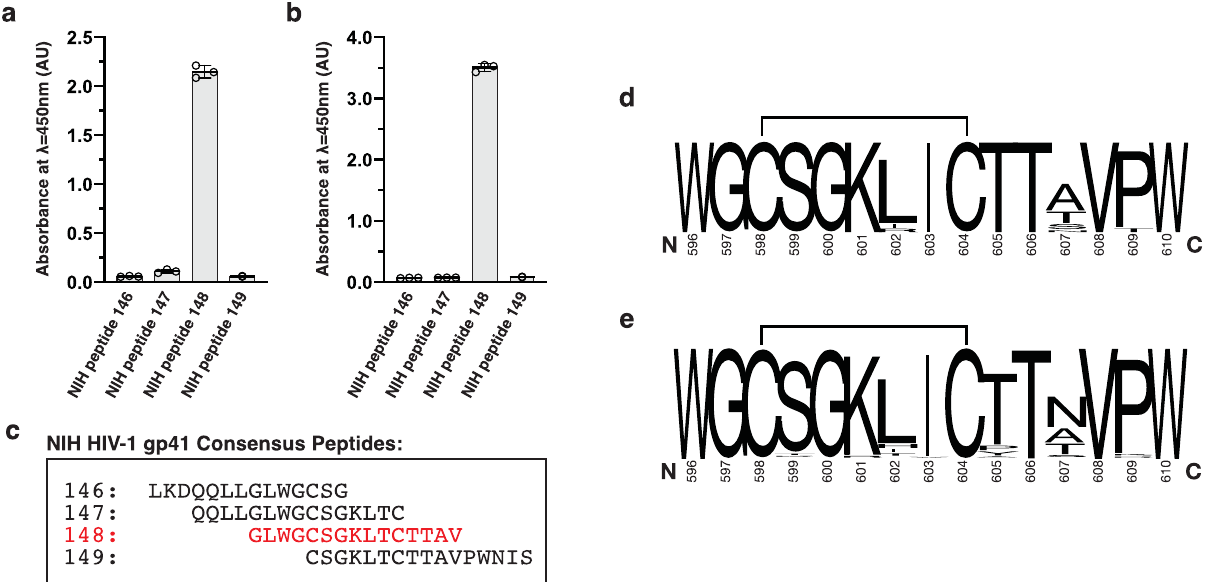
Fig. 1 Epitope mapping of Fab F240 and Fab 3D6 by ELISA. a Fab 3D6 and b Fab F240-binding pro fi les obtained by ELISA. The absorbances were measured as technical triplicates and individual data points shown in the bars ±standard deviation (SD). c Sequences of NIH HIV-1 gp41 peptides used in the ELISA study. d Logoplot of the consensus sequence of the PID motif from HIV-1 M group subtype B that is prevalent in North America and Europe. e Logoplot of the consensus sequences of the PID motif from all HIV-1 subtypes characterized 85,86 . C598 and C604 have been previously demonstrated to form a disul fi de bond, depicted here by a solid